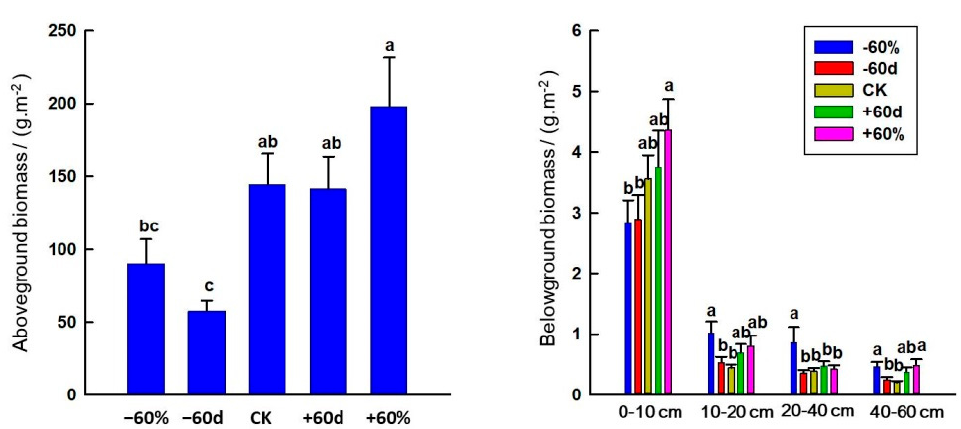
Figure 8. Effects of rainfall changes and soil depth on aboveground and belowground biomass in the sandy grassland. Note: Different little letters indicate significant differences in aboveground biomass among different rainfall treatments ( p < 0.05), as well as significant differences in belowground biomass among different rainfall treatments in the same soil layer ( p < 0.05).